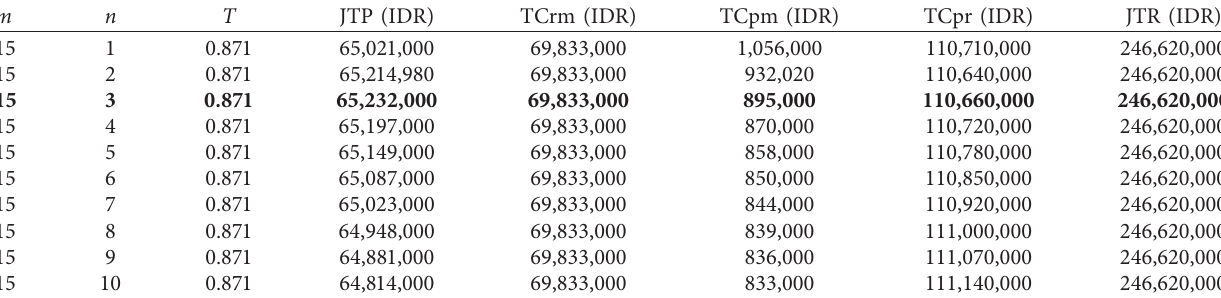
Table 4: Analysis of the sensitivity of the effect of n on cost, revenue, and profit.